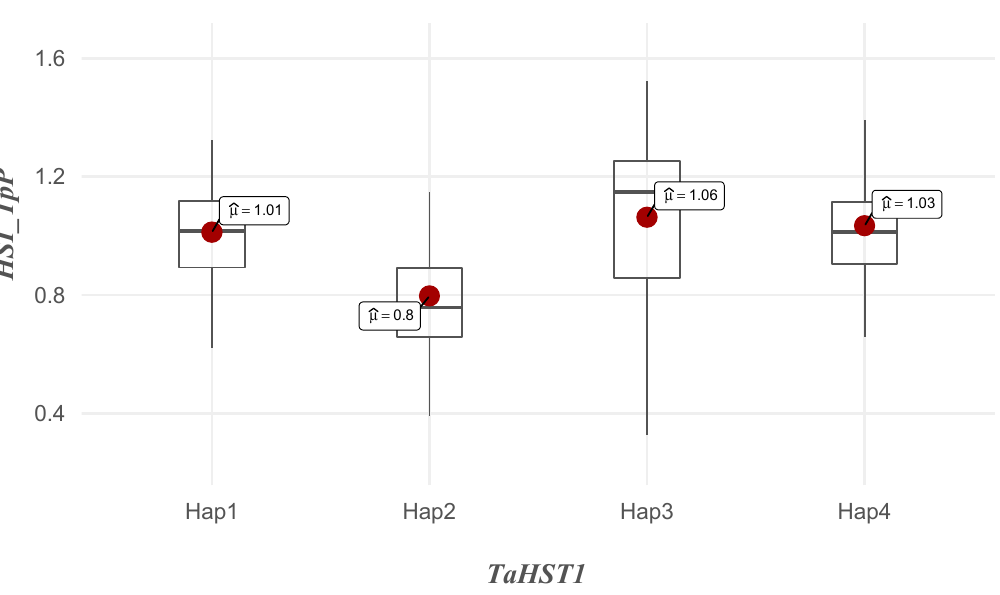
Figure 4. Phenotypic effects of the top four TaHST1 haplotypes on the heat susceptibility index for tillers per plant in synthetic hexaploid wheats .